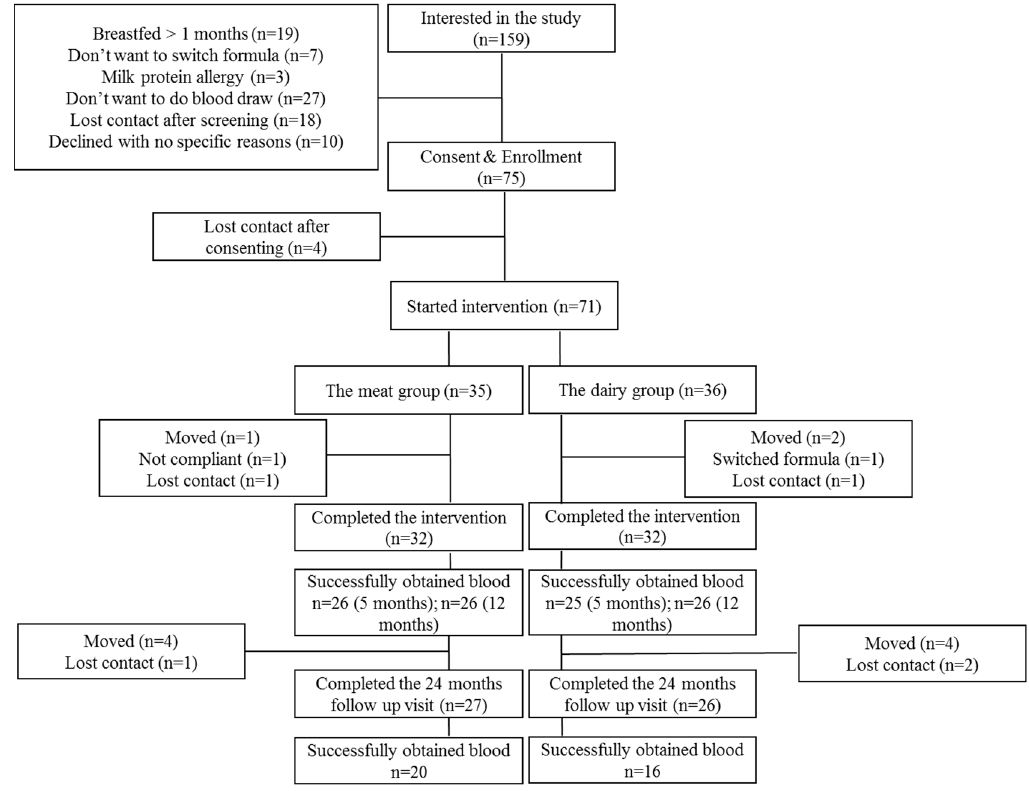
Figure 1. Consort Diagram.